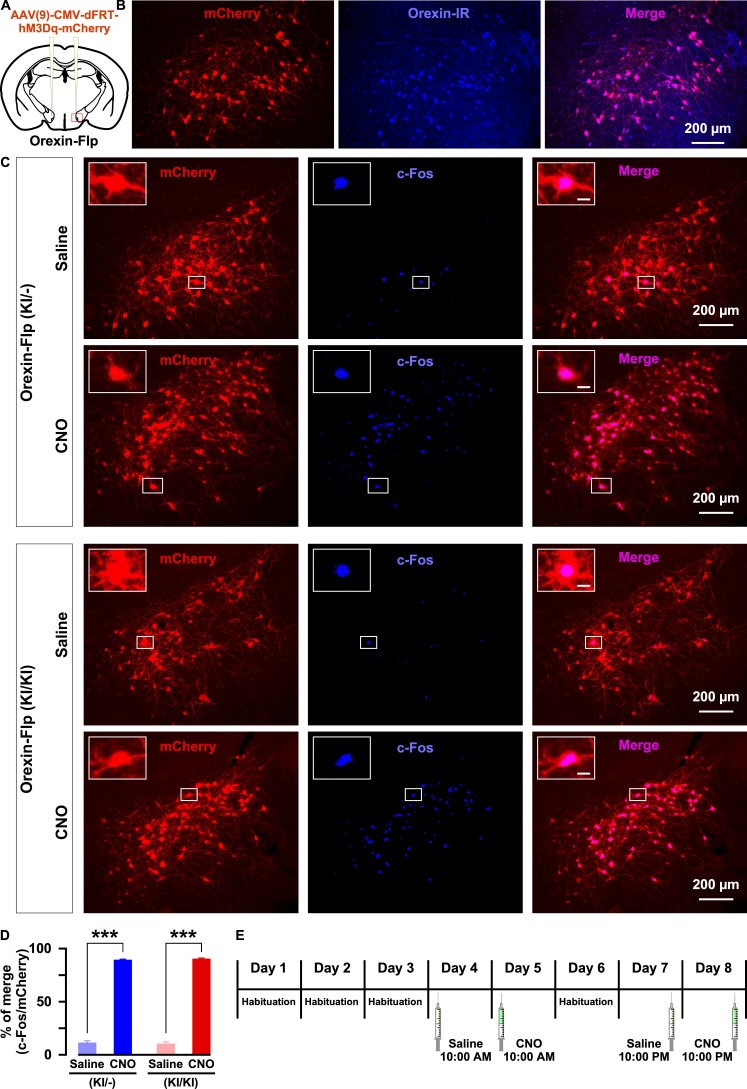
Selective chemogenetic activation of orexin neurons.(A) Intracranial injection of AAV in OF mice to achieve Flp-dependent expression of hM3Dq-mCherry fusion protein in orexin neurons. (B) Representative images showing the expression of mCherry in orexin-immunoreactive neurons in heterozygous OF (KI/-) mice. (C) c-Fos expression after i.p. administration of either saline or CNO in both OF (KI/-) and OF (KI/KI) mice. (D) Summary of the immunostaining data shown in C. CNO administration can significantly increase neuronal activity in both heterozygous and homozygous mice (n = 3 mice per group). (E) Schematic showing the schedule of i.p. administration during sleep recording. The p values were determined by a two-tailed student’s t-test; data represent the mean ± SEM.10.7554/eLife.44927.015Figure 6—source data 1.Source data for Figure 6D.